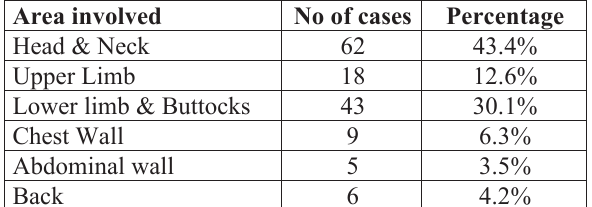
Table-2: Distribution according to location of abscess